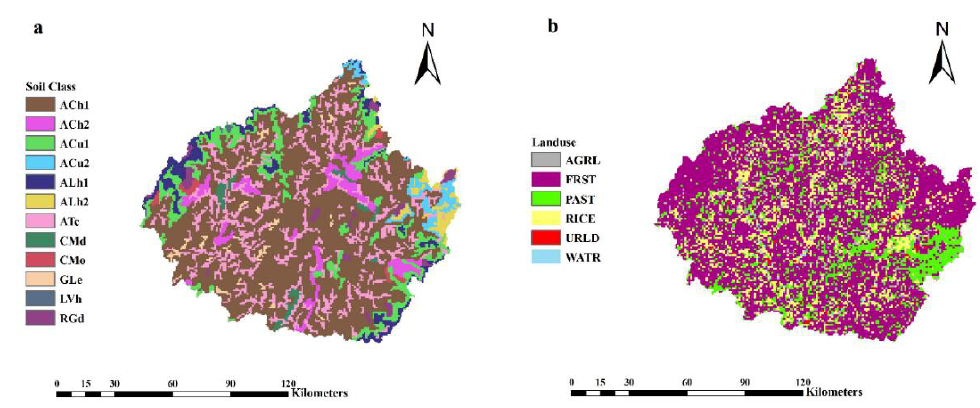
Figure 2. Soil map ( a )and land use ( b ) in Qilijie Basin.